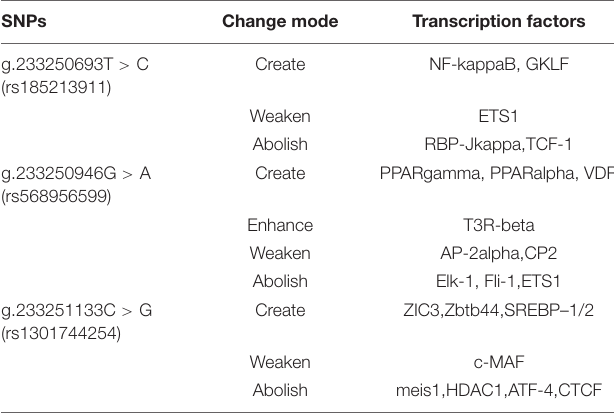
TABLE 8 | Predicted binding sites for transcription factors affected by the SNPs.